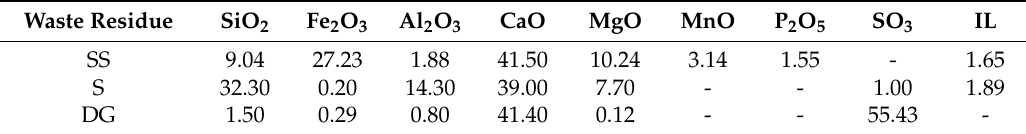
Table 1. Main chemical compositions of the waste residues.